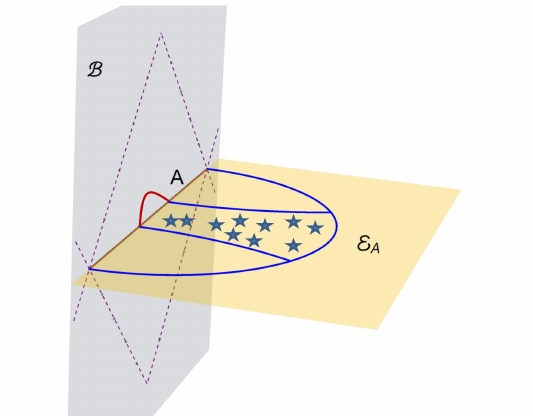
∪ a ∪ a is divided into a as in Fig.4. A 1 2 3 . The red curve on the boundary is 2 2